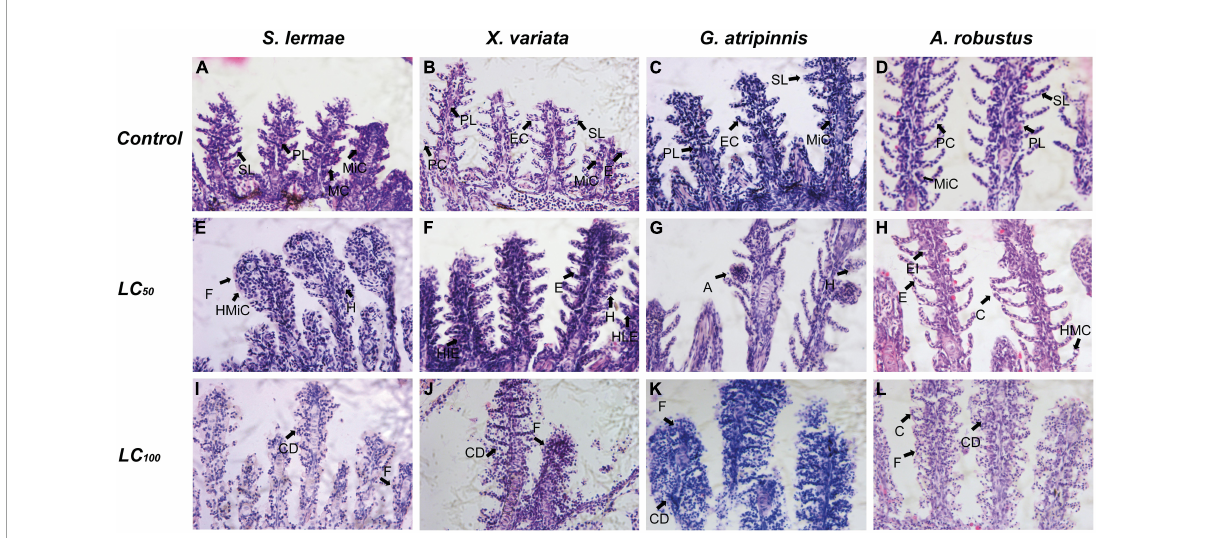
FIGURE3 Effect of acute exposure to NaNO 3 -N on gill histology of four goodeine species. Representative photomicrographs of gill sections stained with hematoxylin and eosin from control (A–D) , concentration closest to the LC 50 (E–H) and LC 100 (I–L) groups. A, Aneurysm of secondary lamellae; C, Change in curvature of secondary lamellae; CD, Cellular degeneration; E, Edema of secondary lamellae; EC, Epithelial cell; EI, Edema of interlamellar epithelium; F, Fusion of secondary lamellae; H, Hyperemia of secondary lamellae; HIE, Hyperplasia of interlamellar epithelium; HLE, Hyperplasia of lamellar epithelium; HMC, Mucus cell hyperplasia; HMiC, Mitochondria-rich cell hyperplasia; PL, Primary lamellae; SL, Secondary lamellae; MC, Mucus cell; MiC, Mitochondria-rich cell; PC, Pillar cell.